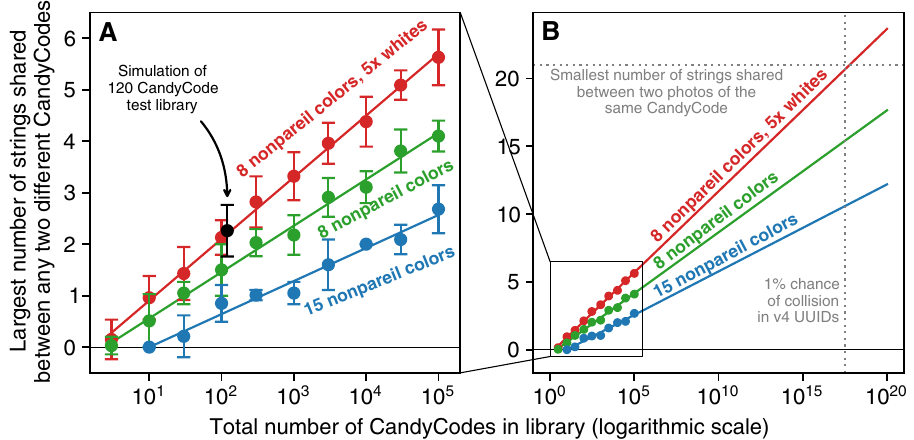
Figure 6. Results from analyzing simulated CandyCode libraries of different designs and sizes. Each point represents the average of 100 separate simulations of the CandyCode library, with error bars ± 1 standard deviation. (A) A simulation of Figure 3’s 120-CandyCode test library with eight colors and a 5 × excess of white nonpareils (black point) predicts an maximum of 2.26 strings shared between any two different CandyCodes; this is in good agreement with the experimentally observed value of 2 maximum shared strings for this library. Simulating larger libraries of eight-color CandyCodes with excess white nonpareils (red points) reveals a logarithmic relationship with library size (red line) ; increasing the library size by a factor of 10 increases the largest number of shared strings by a factor 1.2. Using CandyCodes with eight equal-probability colors (green points and line) reduces the number of strings shared between any two different Codes, so that the same 10 × increase in library size only increases the largest number of shared strings by 0.9. Finally, using CandyCodes with 15 equal-probability colors (blue points and line) further reduces the number of shared strings, so that the same 10 × increase in library size only increases the largest number of shared strings by 0.6. (B) By extrapolating 17 these results to a CandyCode library size of 10 (the number of “version 4” digital UUIDs 21 that must be generated before the odds of having a repeated UUID reach 1% 27 ), we can predict that a CandyCode library of that size using eight colors and a 5 × excess of white nonpareils would have up to 21 strings shared between any two CandyCodes; this equals the smallest number of strings shared between two photos of the same CandyCode in my experiments, so CandyCodes from this library would probably not be suitable for use as universally unique identifiers. However, a similarly-sized library using eight equal-probability colors is predicted to have only up to 15 strings shared, and a library using 15 equal-probability colors should have only up to 10 strings shared. These projections suggest that CandyCodes from these libraries could be used as universally-unique 17 identifiers, and each CandyCode in the library could be distinguished from the 10 other CandyCodes in the